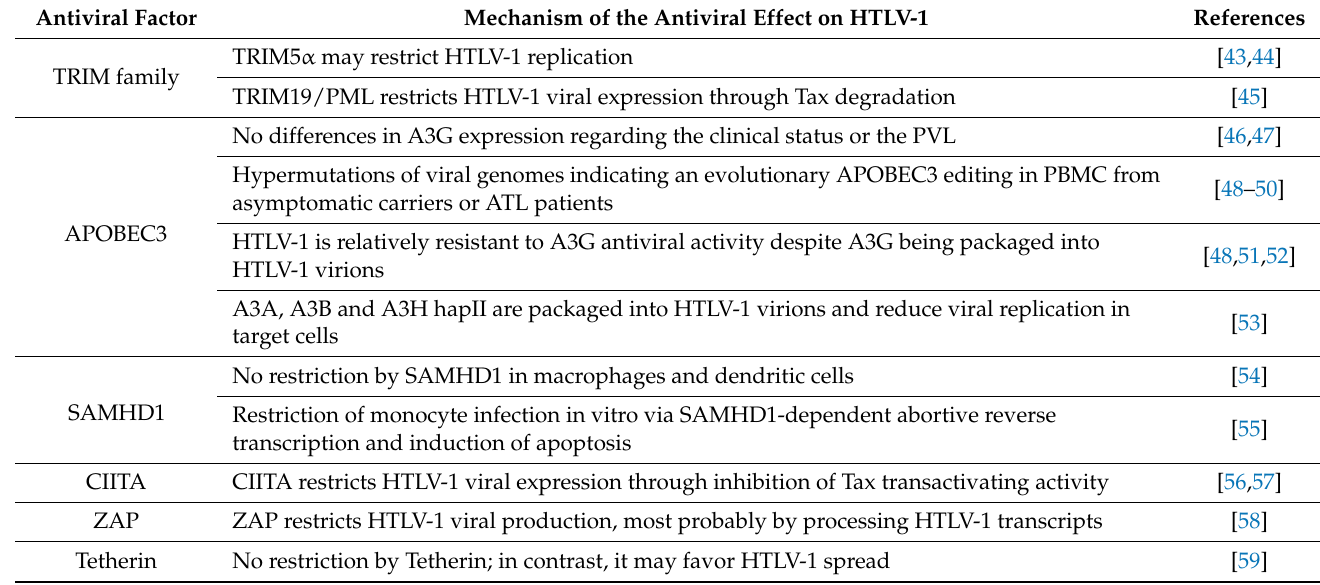
Table 1. Known restriction factors for HIV and their effects on